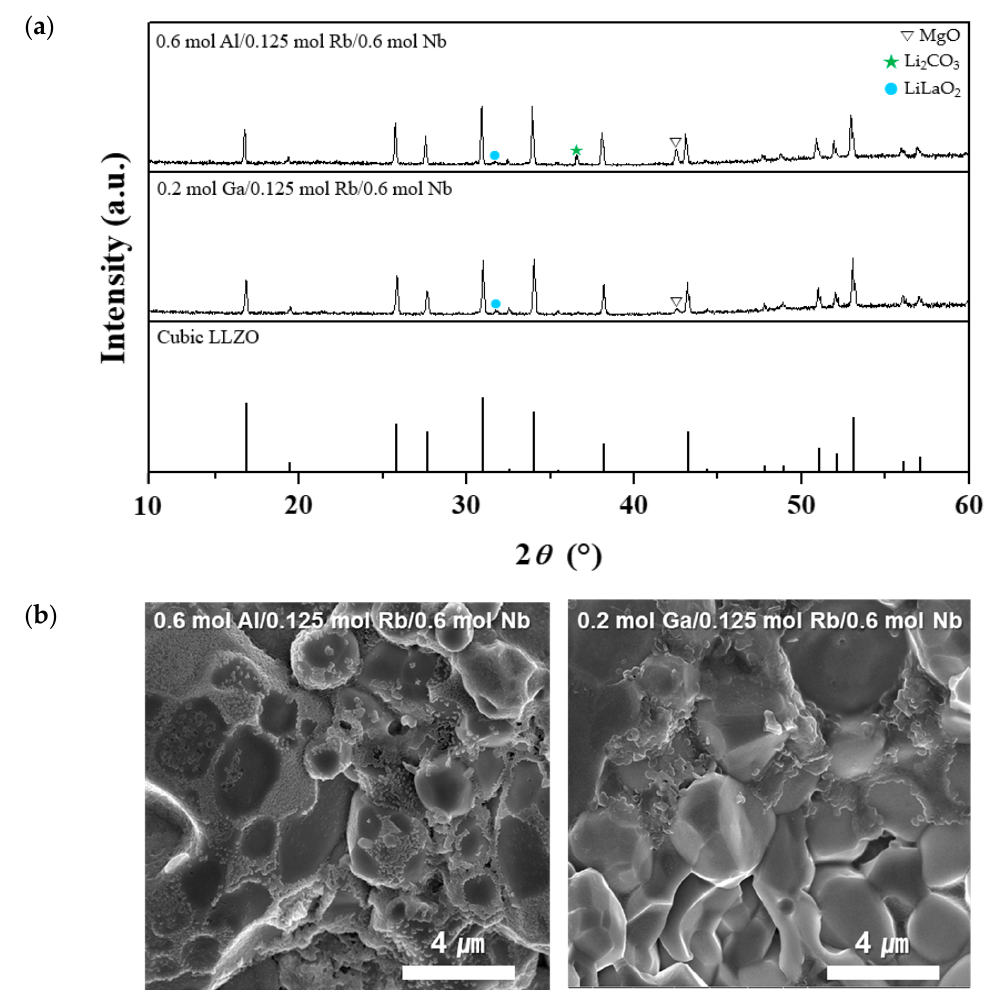
Figure 6. Crystal structure and morphology of tri-doped LLZO ceramics (tri-doping of 0.6 mol Al or 0.2 mol Ga with 0.125 mol Rb and 0.6 mol Nb): ( a ) XRD patterns and ( b ) FE-SEM images of the fracture surfaces.